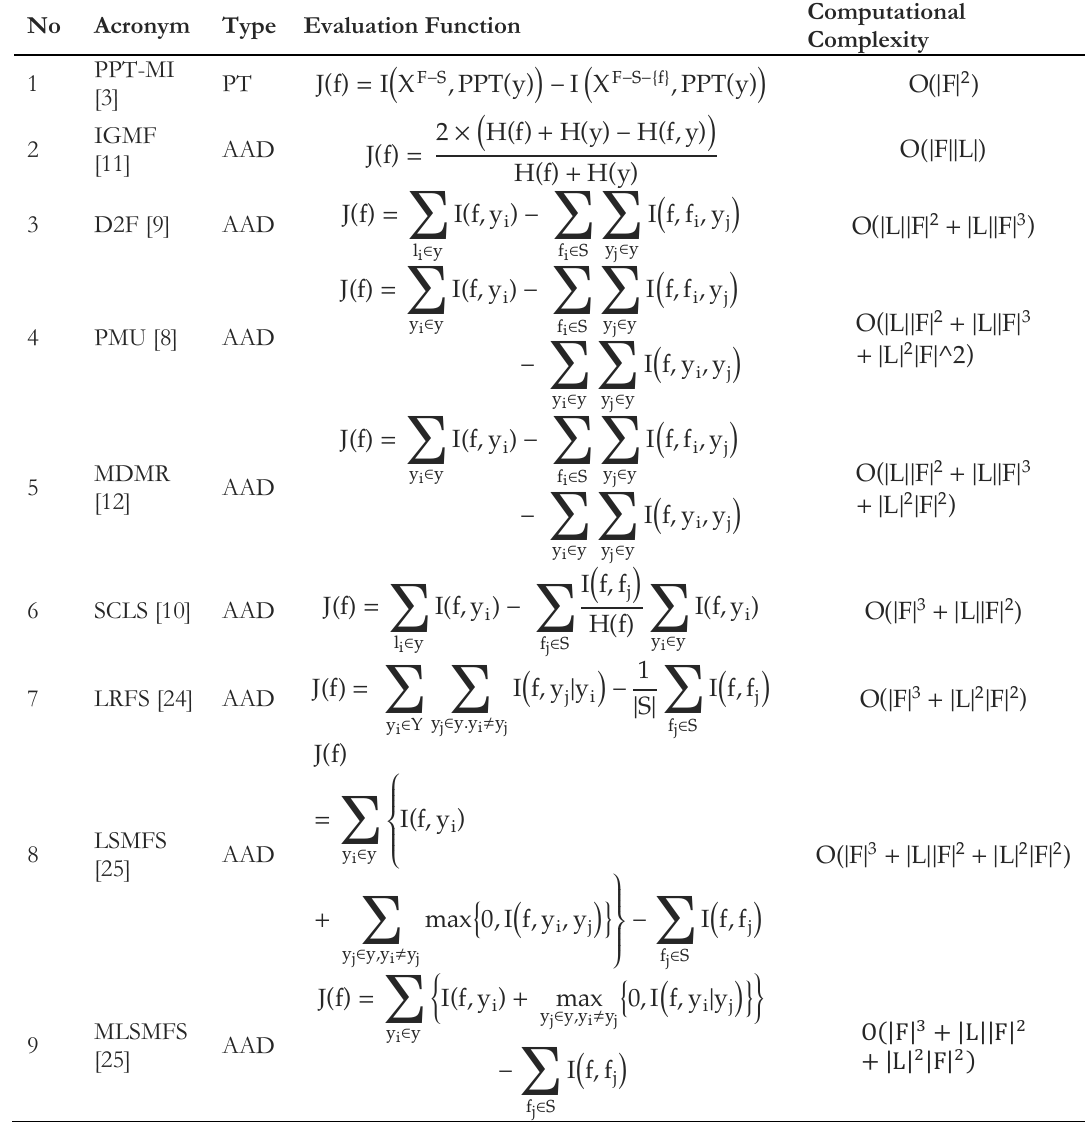
Table 1. List of the multi-label feature selection approaches provided with the